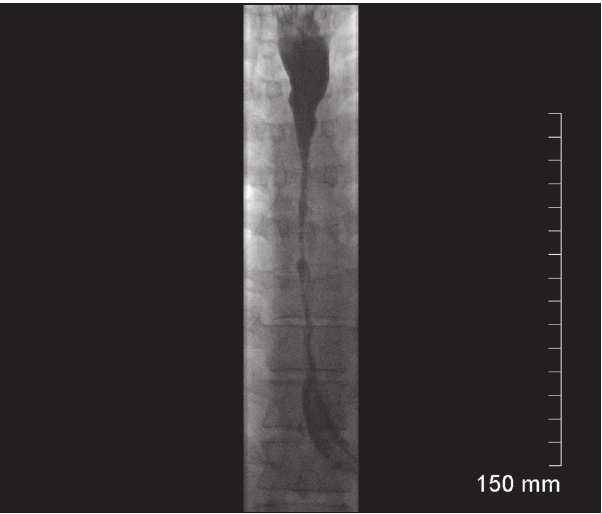
Figure 1) Barium upper gastrointestinal series: A tapered narrowing of the proximal esophagus begins 3 cm below the cricopharyngeus. The narrowing persists over 13 cm and is 2 mm in diameter, demonstrating long-segment stenosis of the esophagus